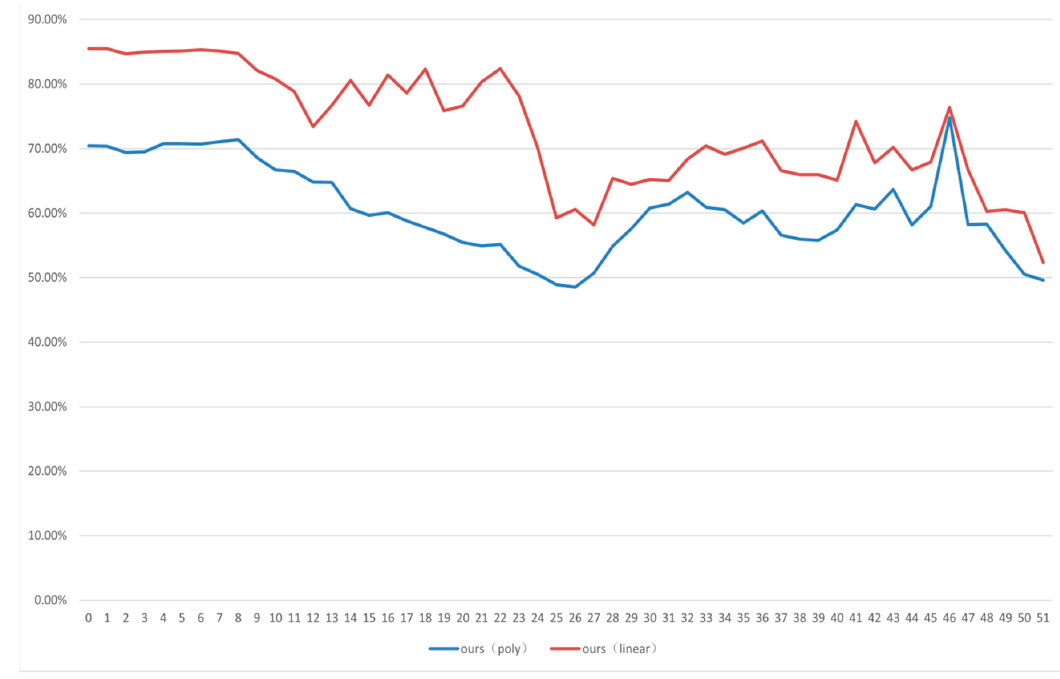
Figure 5. Security experiment results of the different quantization parameters (QPs).